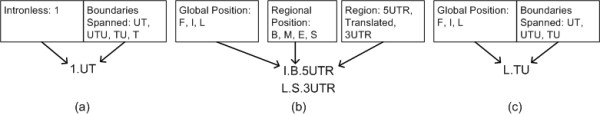
The dimensions of exon categories. Frame (a) identifies the four types of intronless exons. The digit before the period indicates an intronless gene with only one "exon". The dimension value following the period represents which CDS boundaries are spanned. Frame (b) states the 3 parts of a regional exon. The leftmost value states the exon's position with respect to all other exons in the same gene; the middle value indicates the exon's position within its region (which is represented by the rightmost value). Frame (c) represents a CDS-oriented exon, by first stating its global position followed by an indicator of which CDS boundaries are spanned.